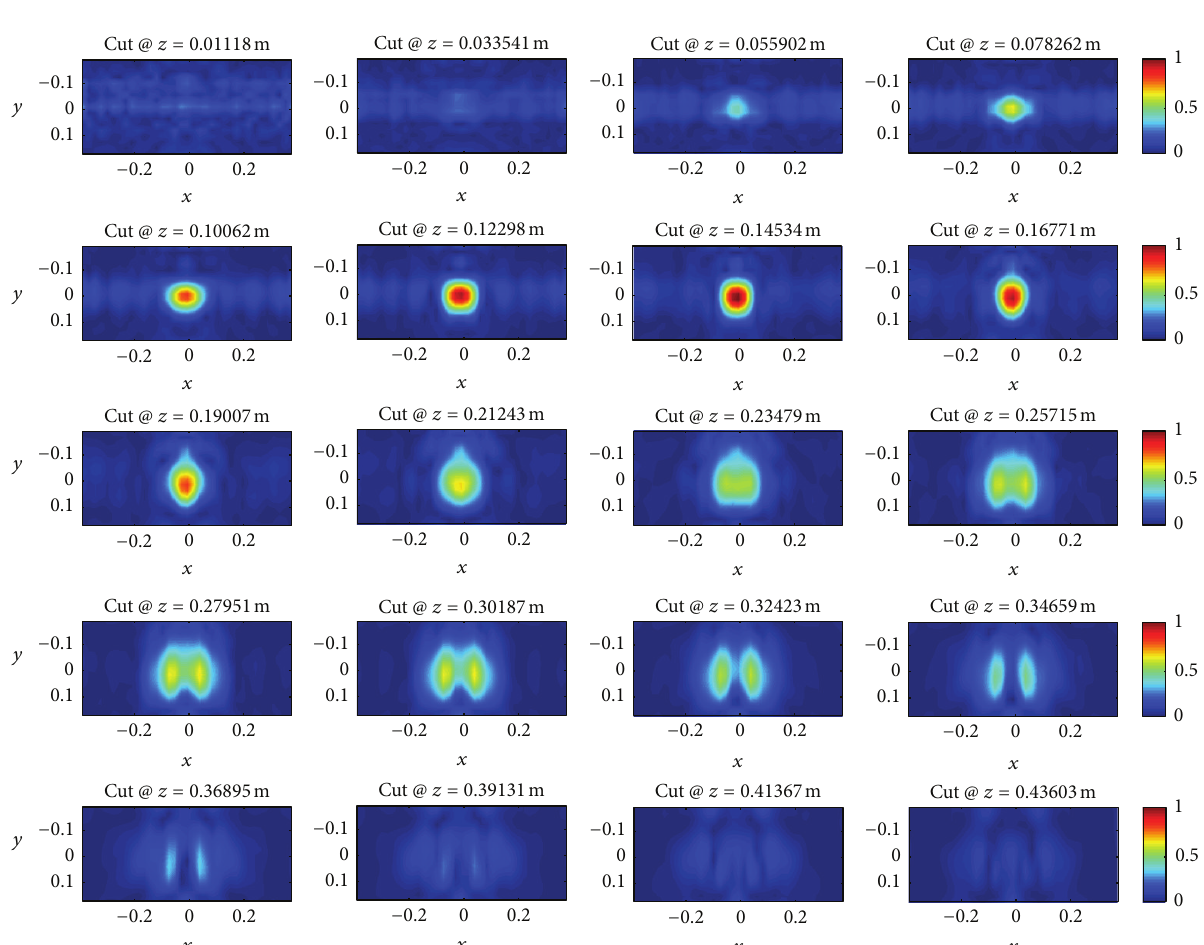
parallel to the air/soil interface and span a planar domain Γ at height ℎ ≈ 0 above the ground. The probing